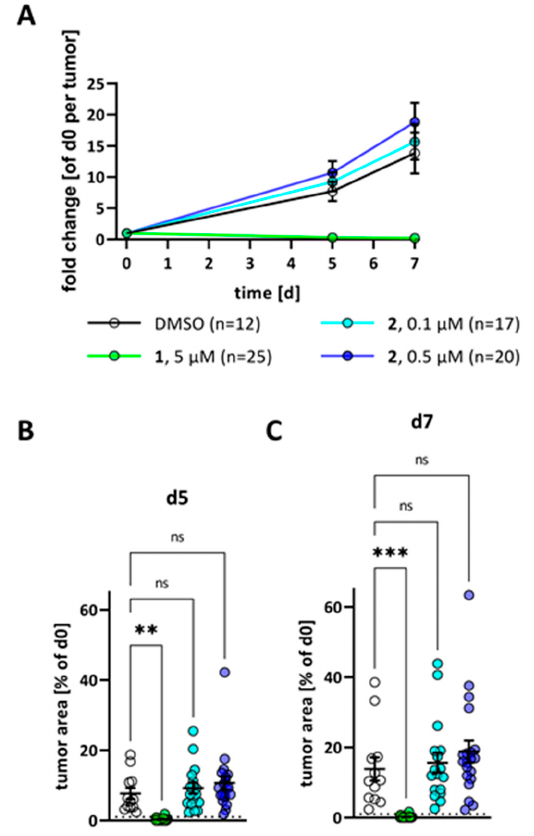
Figure 10. Ex vivo tumor growth assay using organotypic brain slice cultures in the absence (DMSO) or presence of 5 µM of 1 or 0.1 µM or 0.5 µM 2 . ( A ) Growth curves of the NCH644 GFP+ tumors over time after treatment with solvent (DMSO, black line) or 5 µM 1 (green line), 0.1 µM (light blue line) or 0.5 µM 2 (blue line) normalized to the tumor size one day after transplantation (d0) depicted as mean +/ − SEM. ( B , C ) Point plots of the data summarized in ( A ) after treatment for ( B ) 5 days or ( C ) 7 days). Dashed line on y = 1 display the original tumor size. **: p < 0.001; ***: p < 0.0001; two-way ANOVA with Tukey’s multiple comparisons test (GraphPad Prism 7).